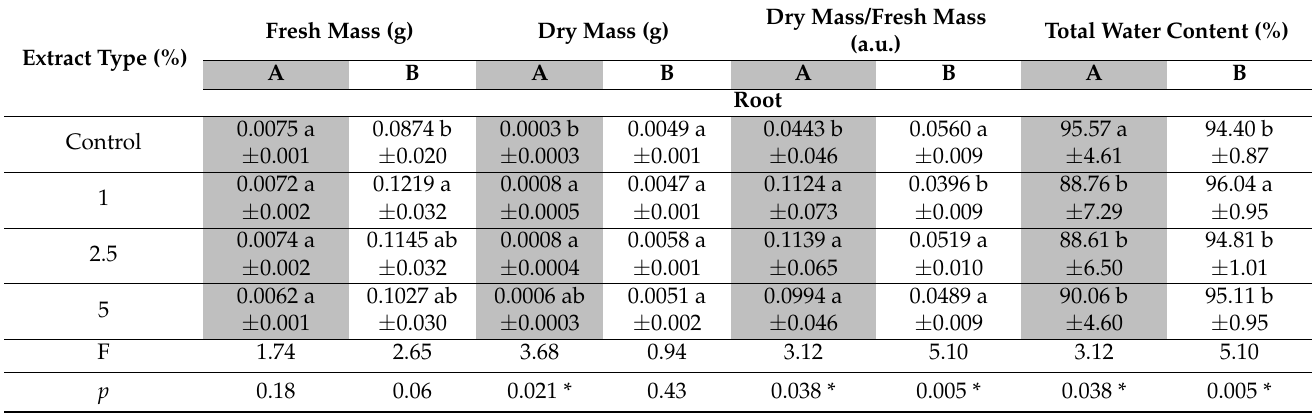
Figure 5. The length of seedlings expressed in (cm) and in (% of control—IP index) of Festuca rubra L. ( A , B ) and Raphanus sativus L. var. radicula Pers. cv. Rowa ( C , D ) treated with aqueous extracts from the organs of Rosa blanda Aiton with various concentrations (1%, 2.5%, 5%); the mean values of the three replicates ( n = 10, ± SD) marked with different letters are significantly different according to Duncan’s test p ≤ 0.05. Table 2. Fresh and dry mass and total water content in seedlings of Festuca rubra L. (A) and Raphanus sativus L. var. radicula Pers. cv. Rowa (B) treated with aqueous extracts from the organs of Rosa blanda Aiton with various concentrations (1%, 2.5%,